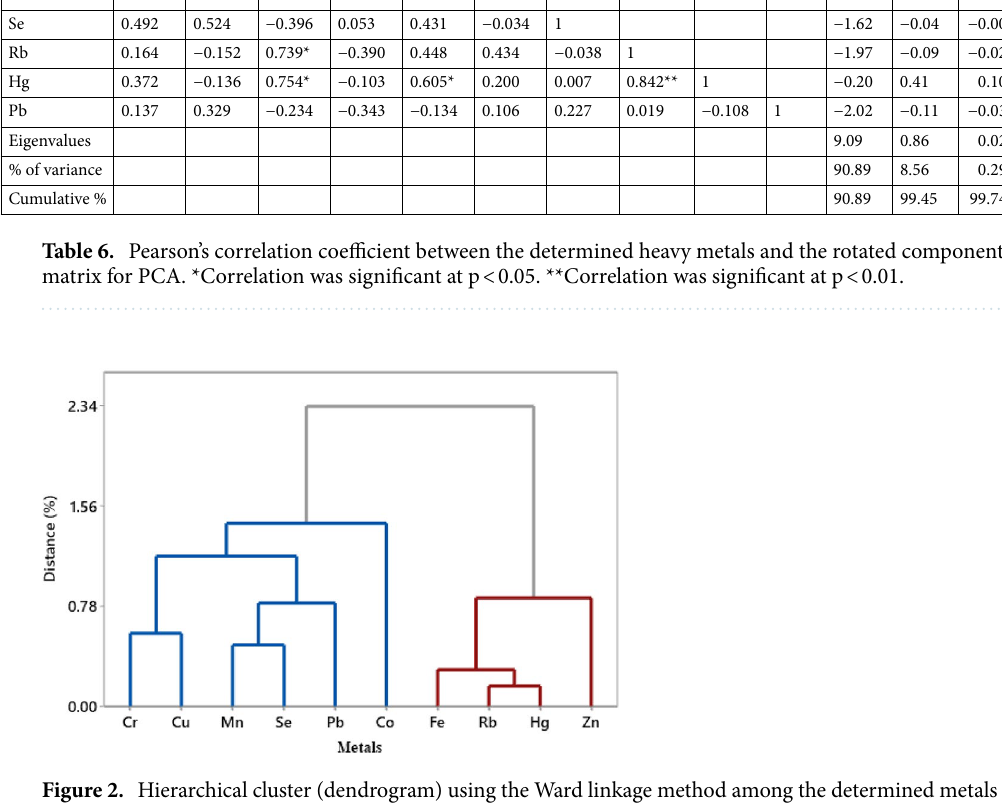
Figure 2. Hierarchical cluster (dendrogram) using the Ward linkage method among the determined metals in dried fish species. The figure was drawn by using SPSS software (Model: IBM SPSS Statistics